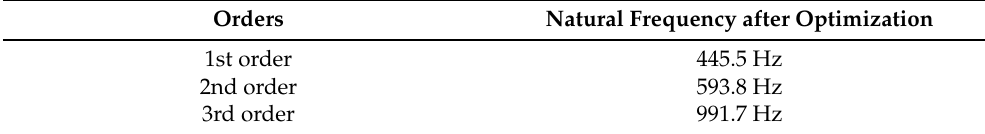
Table 6. Natural frequencies of gearbox